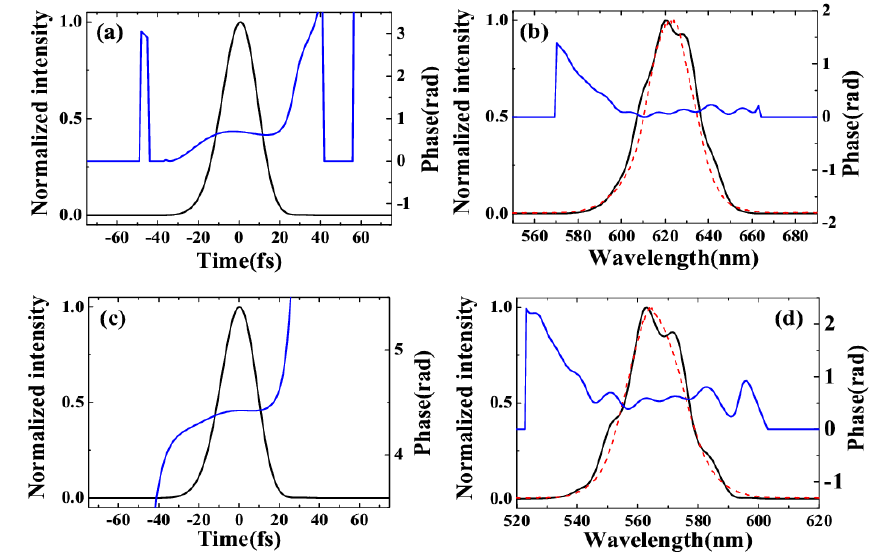
Figure 14. Recovered intensity profile and phase of (a) AS1 and (c) AS2. Recovered spectrum (black solid curve), spectral phase (blue solid curve), and measured spectrum (red dotted curve) of (b) AS1 and (d) AS2